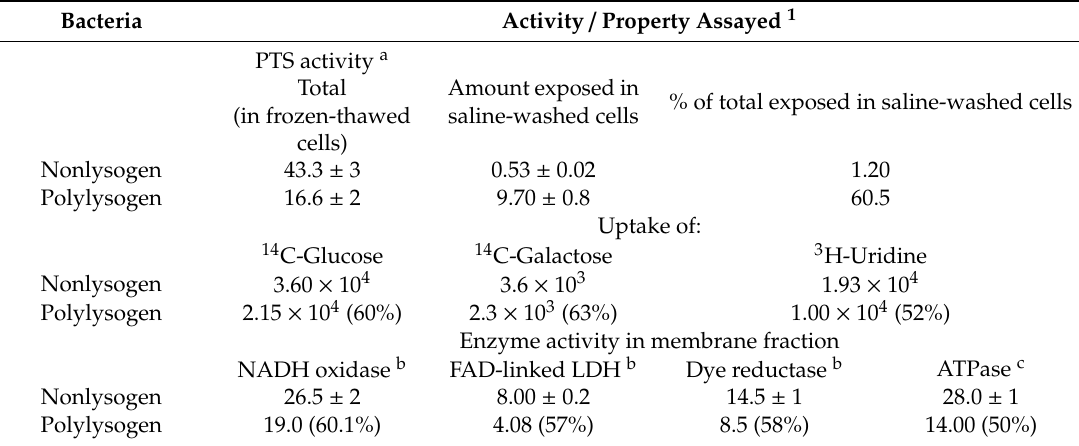
Table 1. The inner membrane activities of the polylysogen and